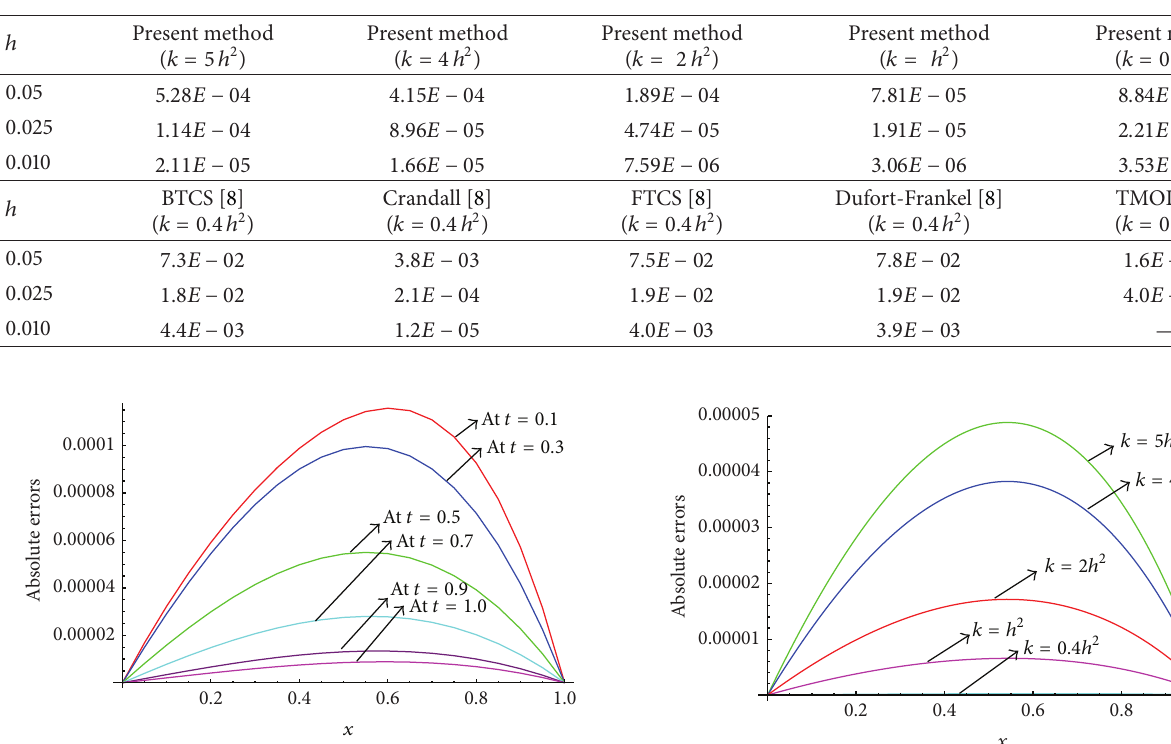
Table 6: Relative errors of numerical method at 𝑢 (0.6, 1.0) for Example 2 with various values of space step.